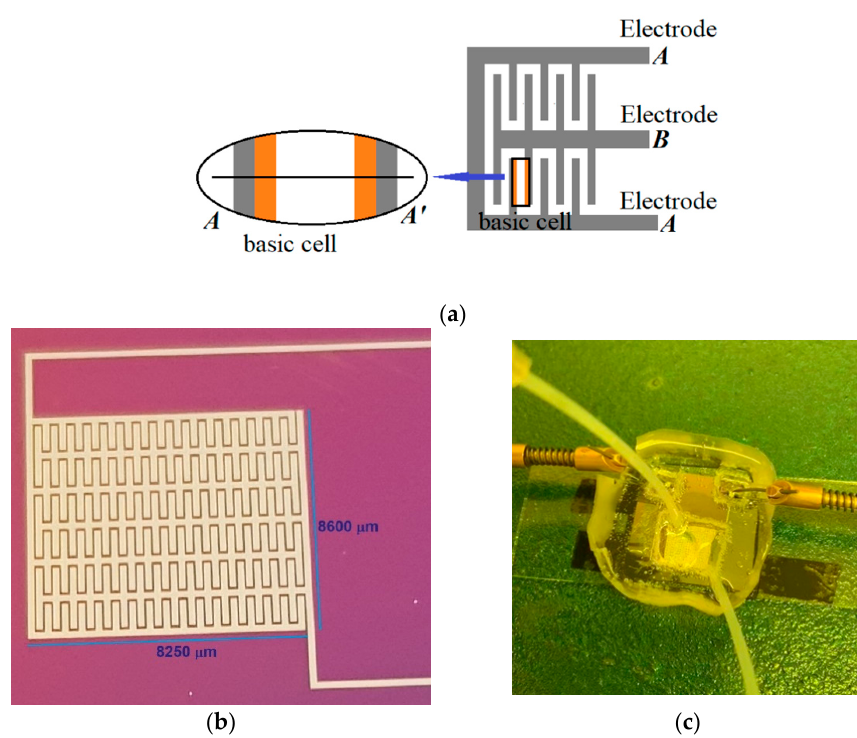
Figure 1. The main characteristics of the coplanar capacitive sensor (CCS) are shown: ( a ) The schematic structure is shown, and the basic cell of the device is defined; ( b ) An image of the fabricated device over a silicon substrate with 200 µ m metal width; ( c ) The physical device implantation for liquid sensor